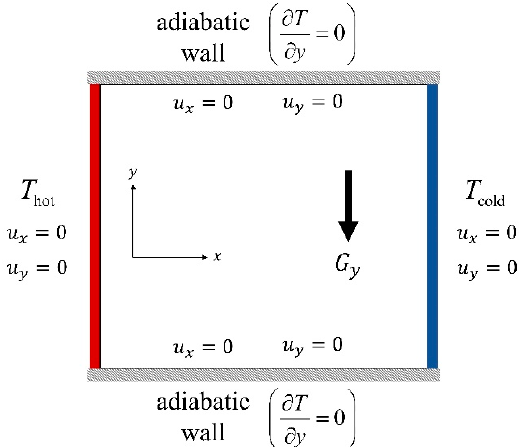
Figure 1. Domain configuration for two-dimensional natural convection in a differentially-heated cavity.